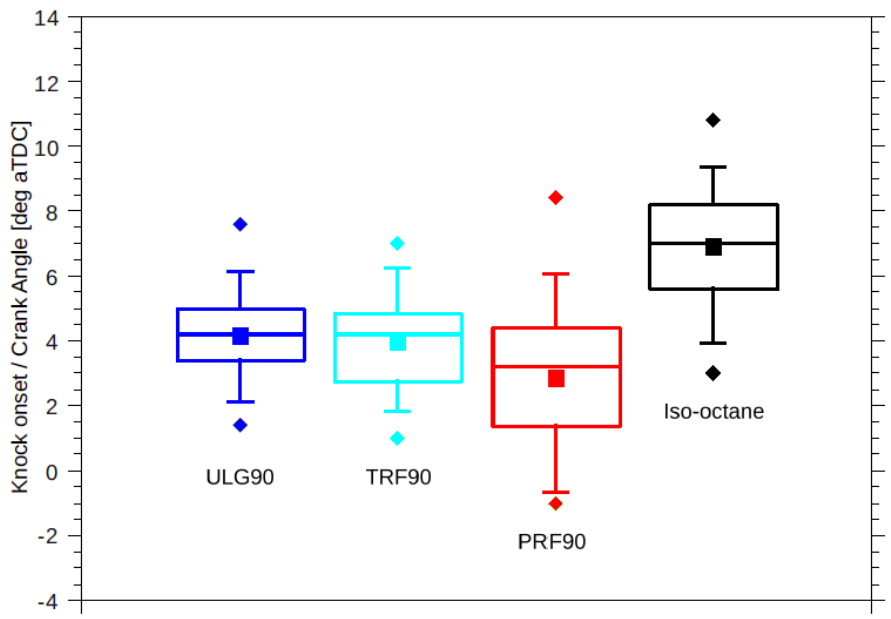
Figure 4. Statistical variation in measured knock onsets for 100 combustion cycles of the four fuels tested. Squares: mean knock onset, diamonds: earlier and latest knock onsets, box: 25/75 percentile, whiskers: 5/95 percentile.